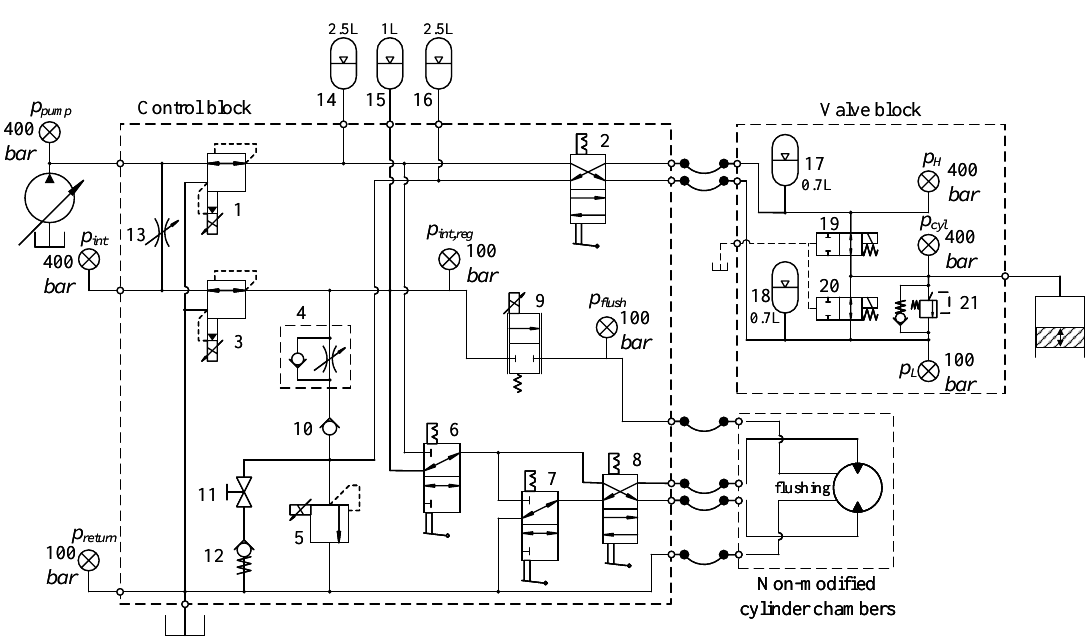
Figure 12. Hydraulic diagram of the test rig